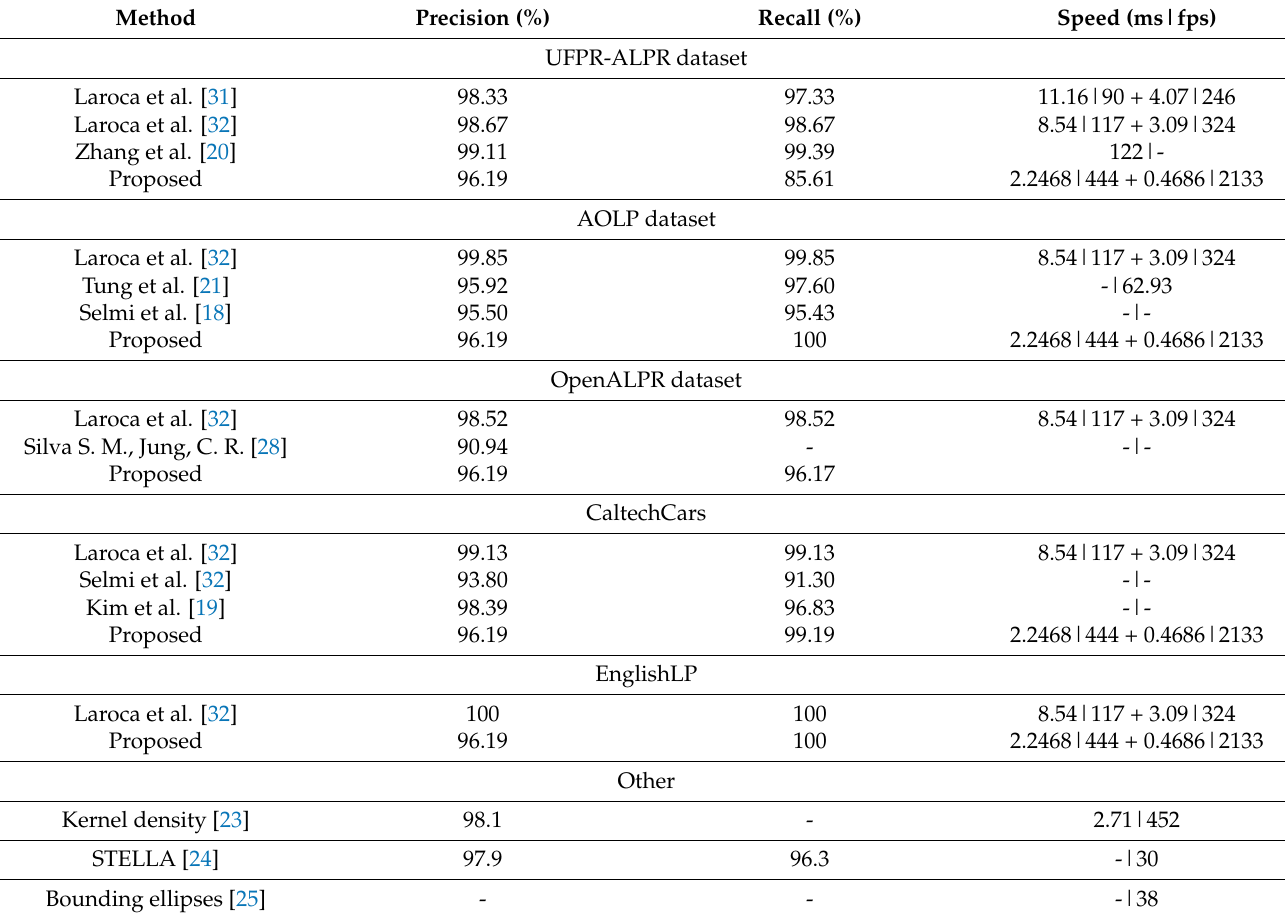
Table 2. Detection performance comparisons for various datasets. Precision for all datasets is average precision, recall is precise for each dataset, and speed is average for all